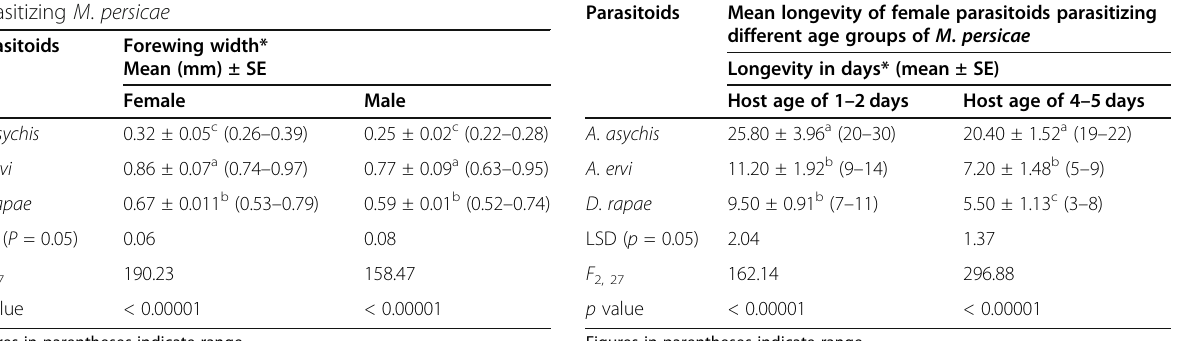
Figures in parentheses indicate range Mean values within the columns bearing the same letters are not significantly different — LSD ( p = 0.05) *All values are mean of 10 observations